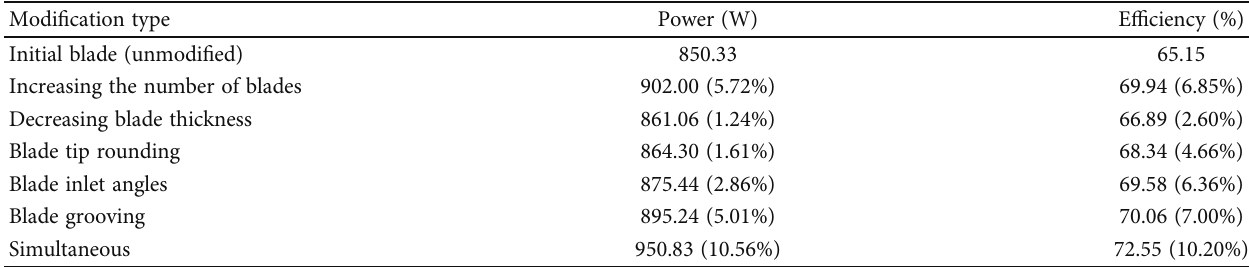
Figure 17: Simultaneous performance improvement of PAT. Table 5: Comparison of the modi fi cation